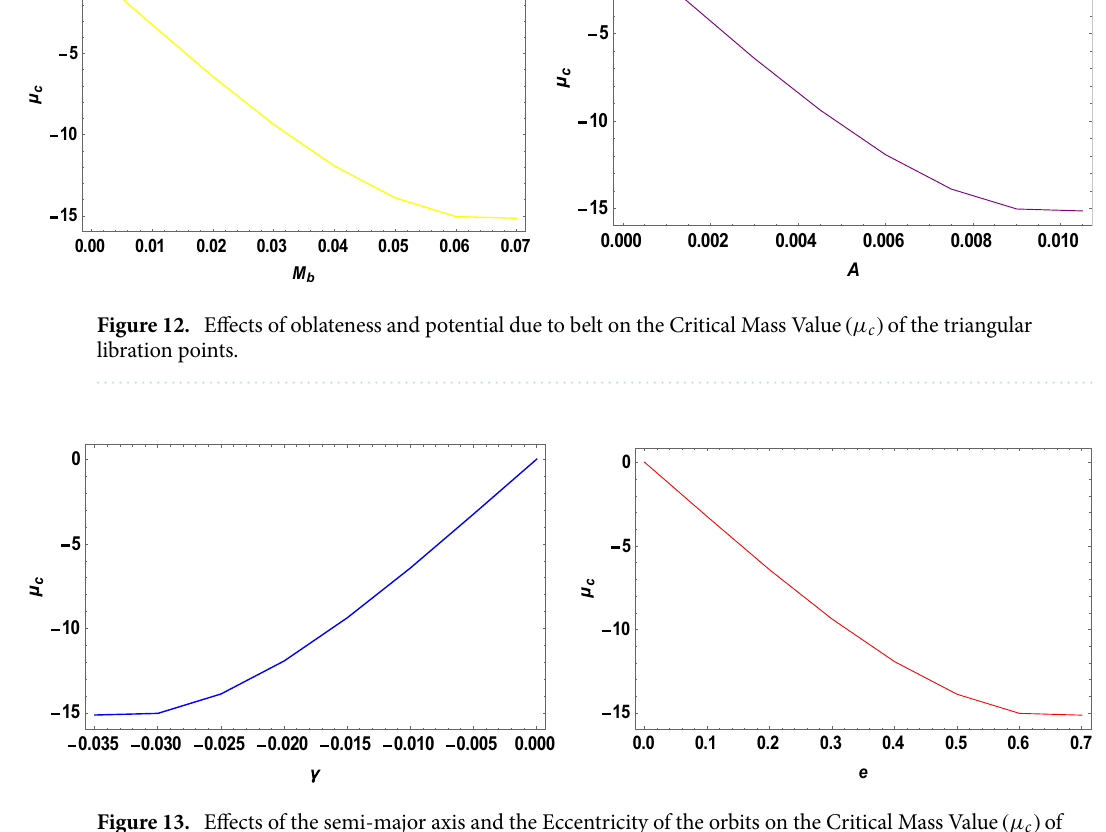
Figure 13. Effects of the semi-major axis and the Eccentricity of the orbits on the Critical Mass Value (µ c ) of the triangular libration